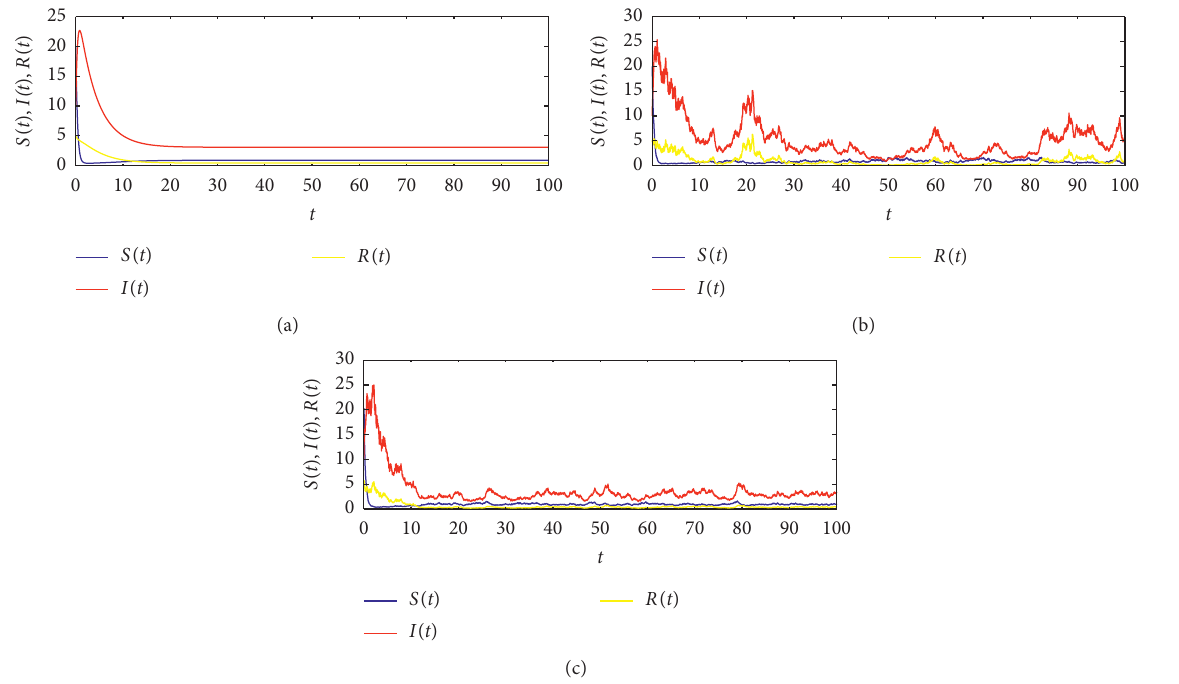
� 0 . 29 , σ � 0 . 25 , and σ � 0 . 5. 1 2 3